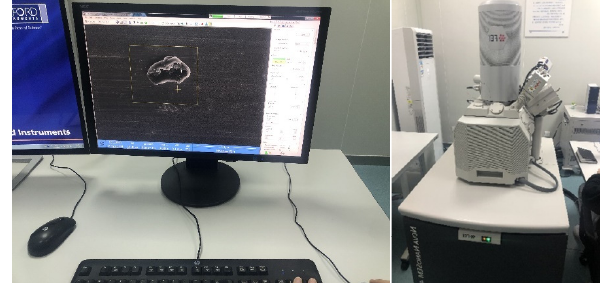
Figure 6. Field emission scanning electron microscope